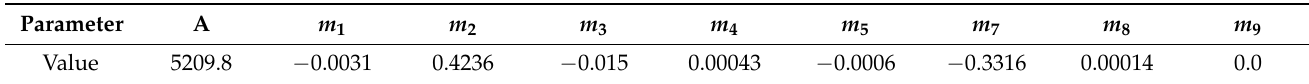
Table 3. Flow stress model parameters of steel 38MnSV6 used in simulation of forging.